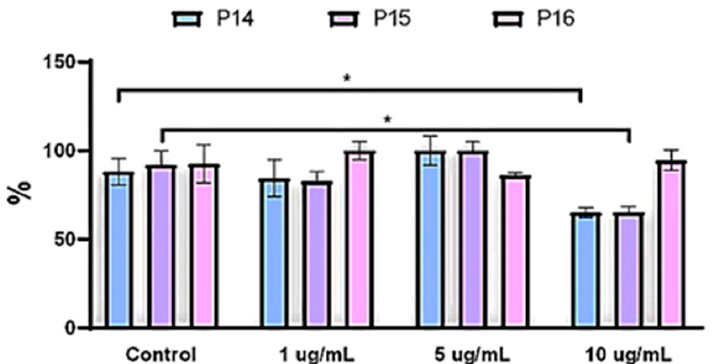
Figure 12. MTT cell viability assay on U87 cell line with varying concentrations of BPEI-coated IONRs after 48 h. Error bars represent the standard error of the mean (SEM). The statistical significance level and indicated with (*) for p < 0.05.